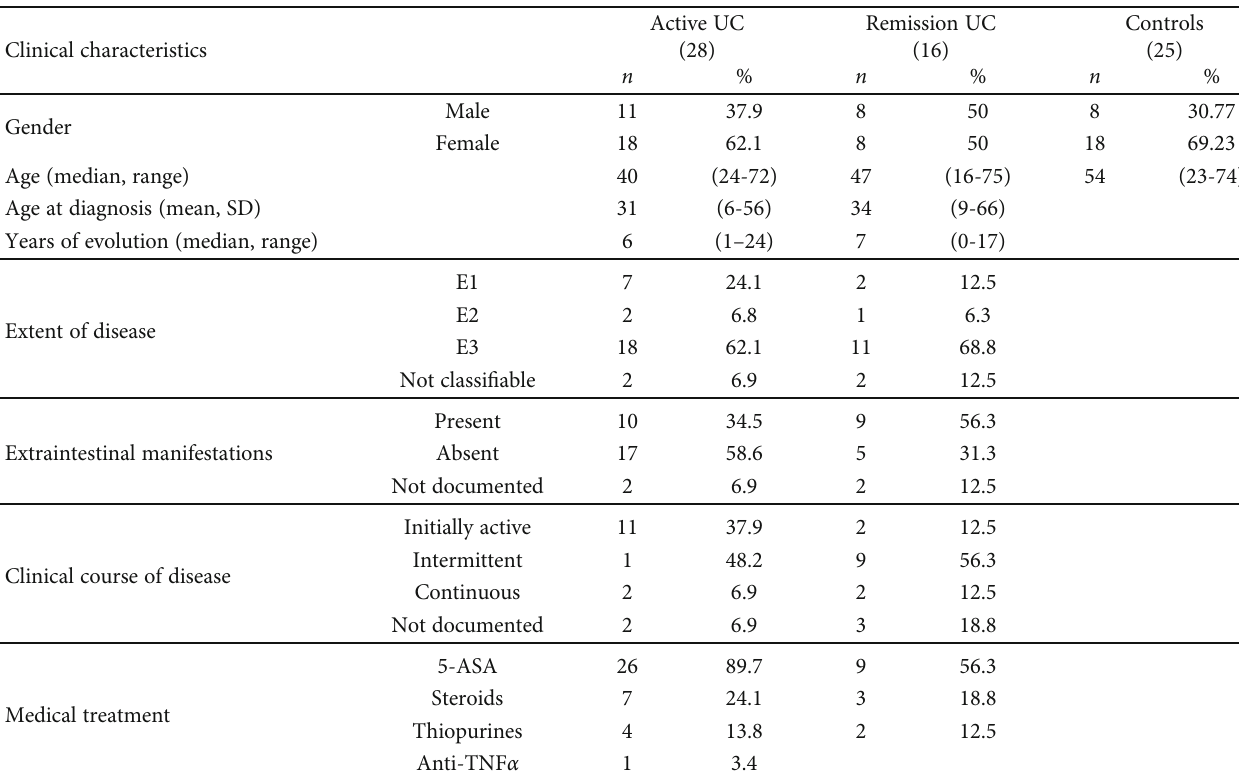
Table 2: Sociodemographic characterization of the patients and